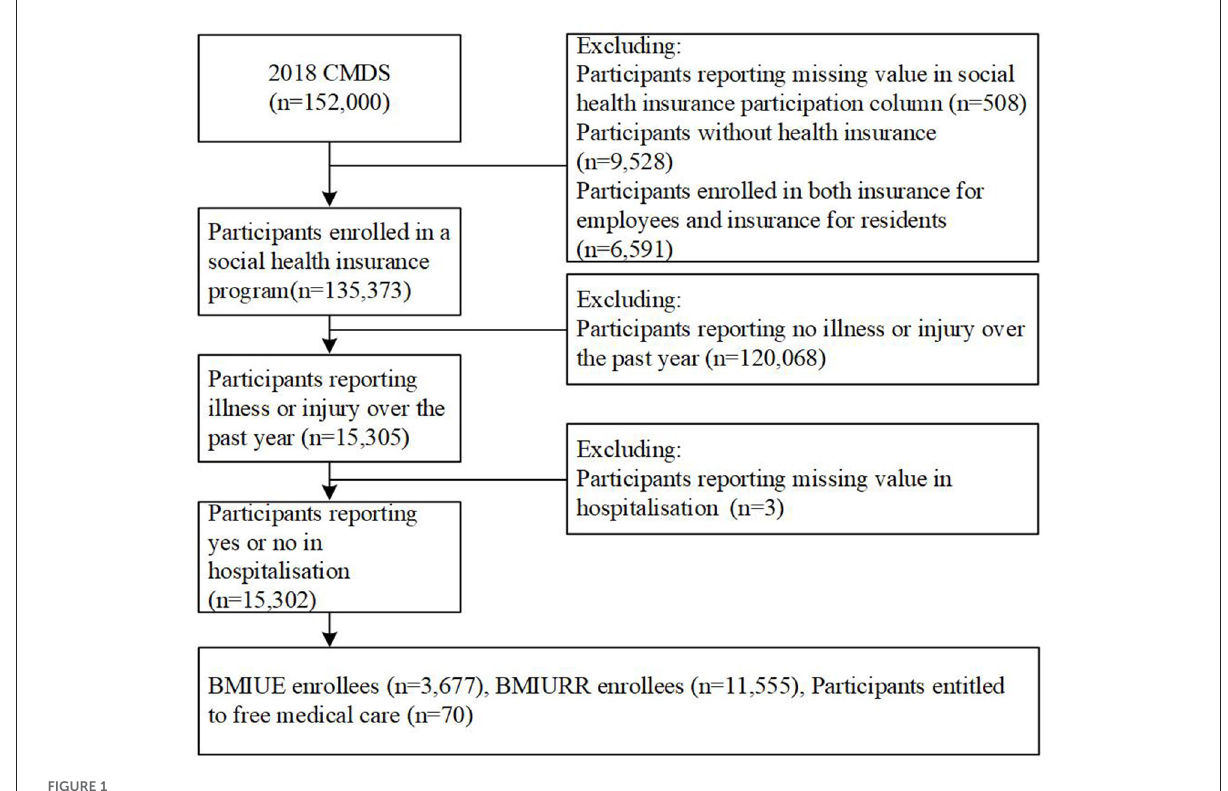
FIGURE1 Screening flowchart of study